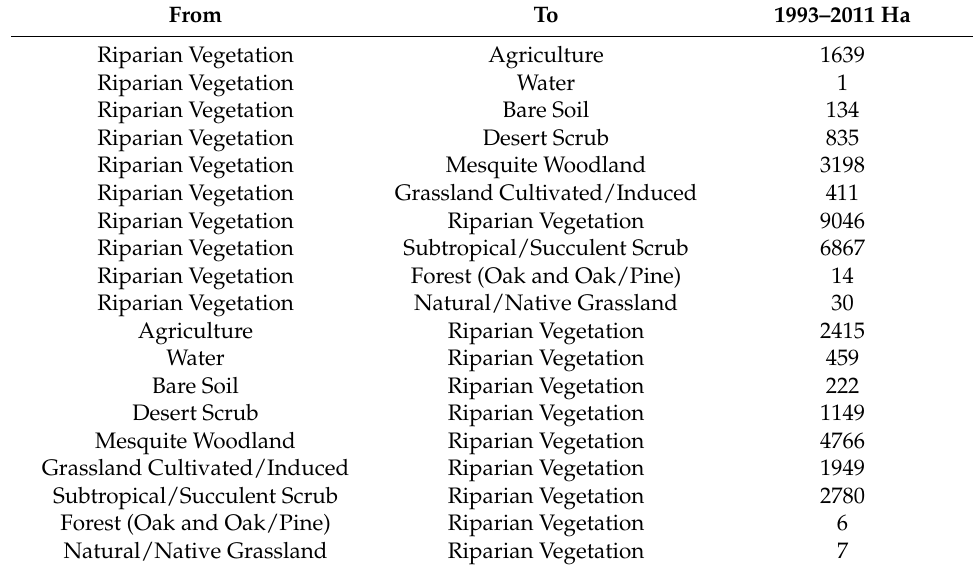
Table 6. Land cover trends relative to the Riparian Vegetation class along the 5 km buffer in both sub-watersheds.